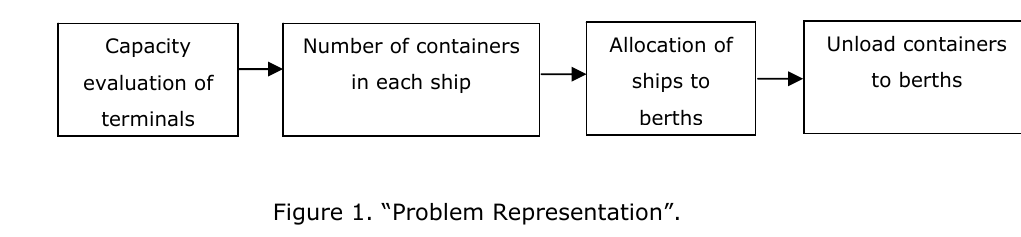
Figure 1. “Problem